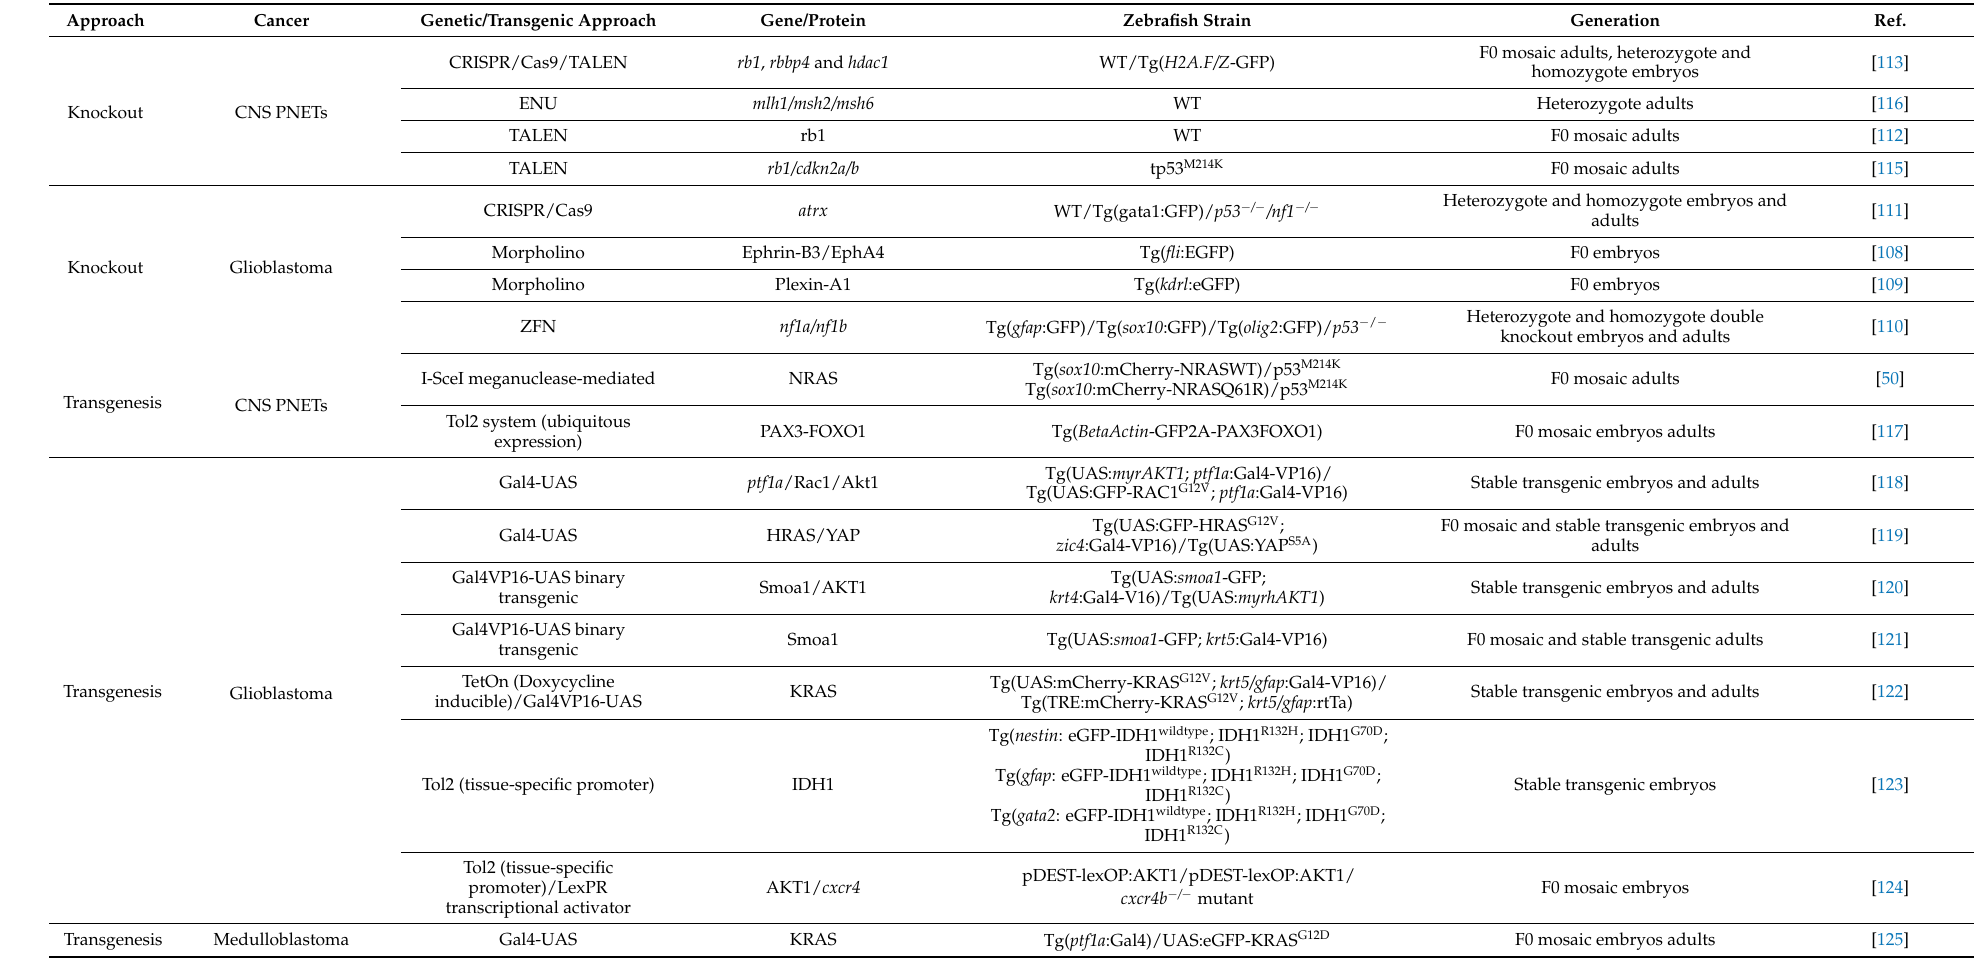
Table 1. Genetic models of paediatric brain tumours in